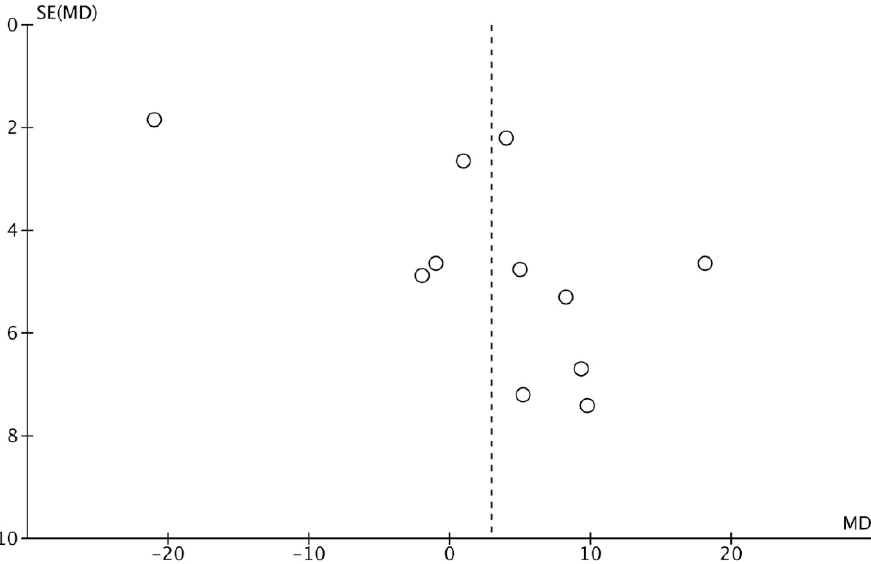
Figure 7. Galbraith plot for TUN (control group) versus CAF (test group) when comparing the percentage of root coverage after surgical treatment, constructed to examine the contribution of individual studies to the heterogeneity metrics and identify outliers. The vertical axis represents the observed effect sizes standardized according to their corresponding standard errors (y = MD/SE[MD]) against precision on the horizontal axis (x = 1/SE[MD]). The regression diagonal line is projected from the origin (0, 0), and the approximate 95% confidence intervals run between the two intermittent parallel lines at ±2 units above and below the regression line. The ID labels were also included, allowing an easier identification of the studies. The study below the confidence lim- it was identified as an important outlier (Tozüm et al. [41], depicted as a red circle) that contribut- ed disproportionately to the observed heterogeneity. Abbreviations: CAF, coronally advanced flap; MD, mean difference; SE, standard error; TUN, tunnel.